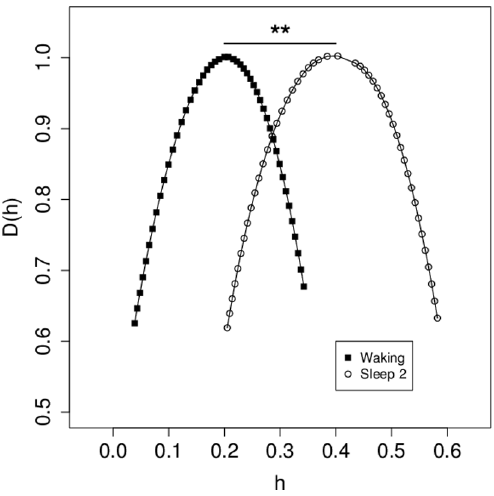
Figure 4. Comparison between MF-DFA spectra of from waking and sleep stage 2. For 14 subjects with 8 m of EEG from both waking and sleep stage 2 per subject, EEG was divided into 16 segments of 30 s each, and MF-DFA spectra were calculated for each segment (224 segments for each state of consciousness). Average MF-DFA spectra for each consciousness state shown here were calculated by averaging across individual spectrum values for each subject. **: p , 0.001 for effect of state of consciousness by general linear modeling based on mean_h.